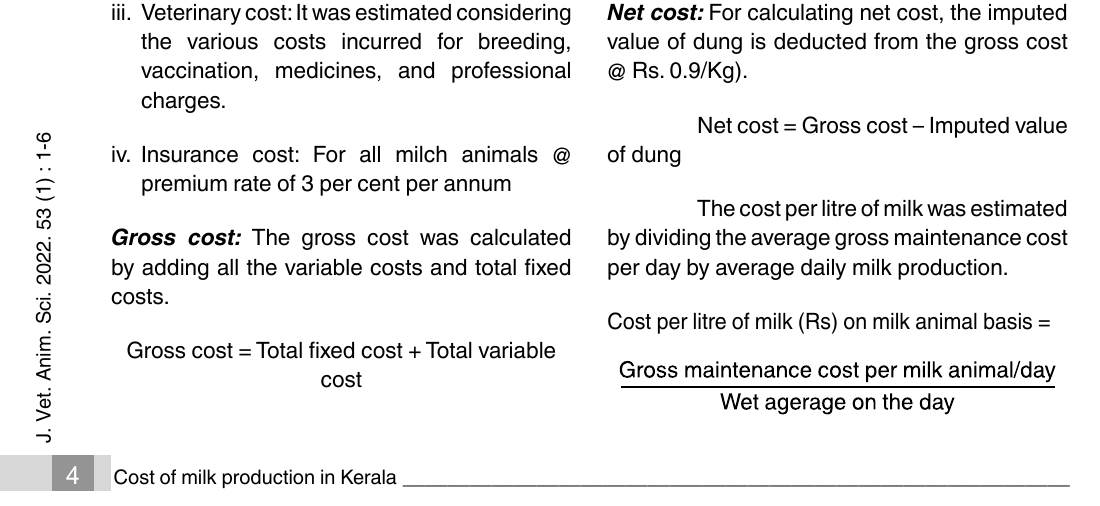
small Medium Large Overall % of % of % of % of the the the the Mean Mean Mean Mean gross gross gross gross cost cost cost